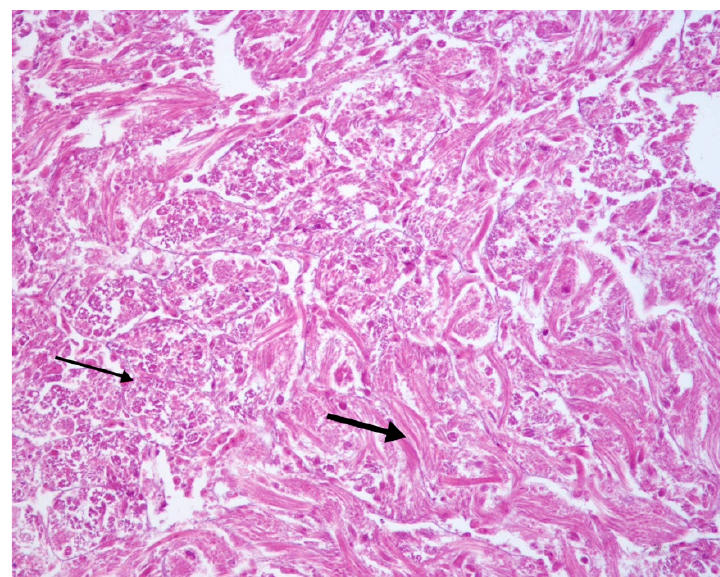
Figure 2 . Testes. Altered seminiferous tubules. Disappearance of the seminiferous epithelium and the lumen; necrosis of follicular and germ cells (thin arrow); numerous spermatozoa (thick arrow); absence of spermatocytes and spermatogonia. H-E 20×.